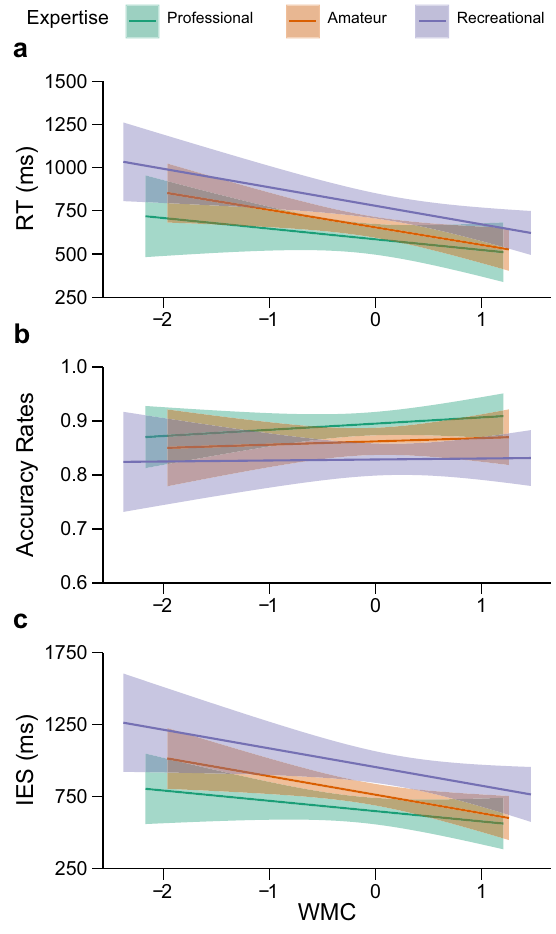
Fig. 2 The effect of WMC on the a RTs (in ms), b accuracy rates, and c IESs (in ms) in tactical decision-making at different levels of soccer